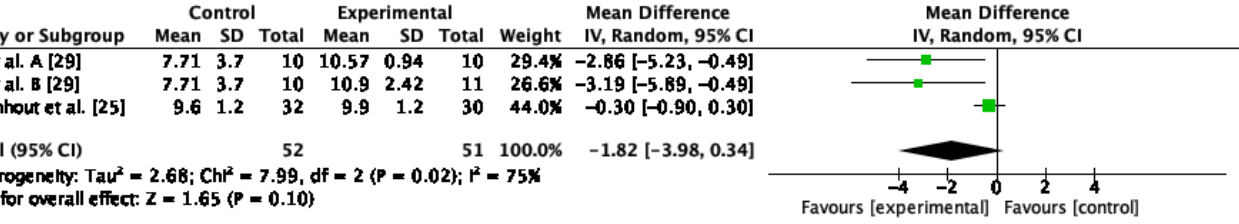
Figure 10. Forest plot of subacromial space for conservative therapy versus control/sham and con- servative therapy versus other conservative therapy. Lo et al. A compared KT versus control inter- vention. Lo et al. B compared stretching versus control intervention.